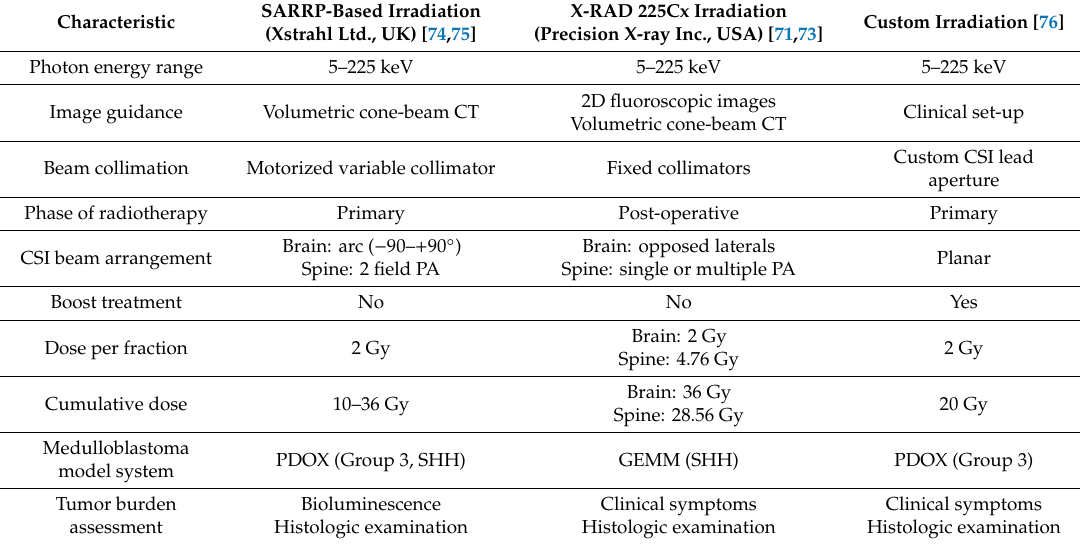
Table 1. Comparison of therapy and model characteristics of select commercial preclinical irradiation systems and custom approaches used to deliver craniospinal irradiation to murine models of